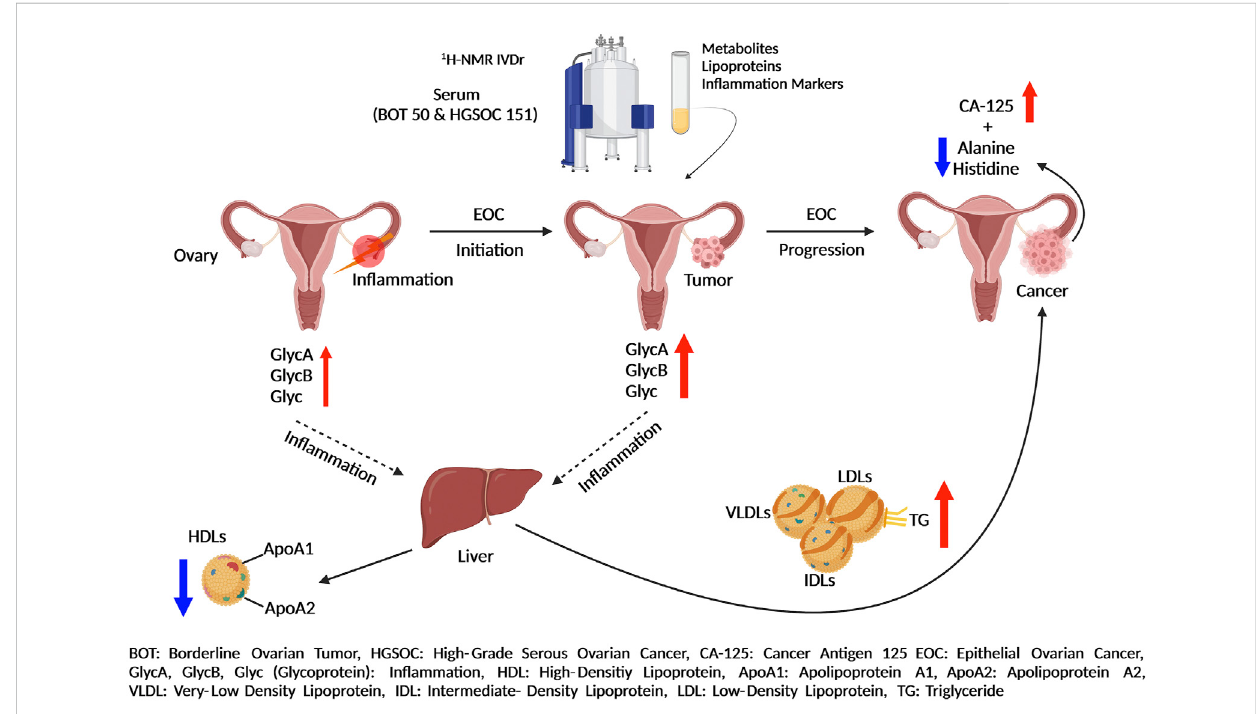
FIGURE 1 Summary of epithelial ovarian cancer development and progression by in vitro diagnostics research 1 H-NMR-based metabolomics